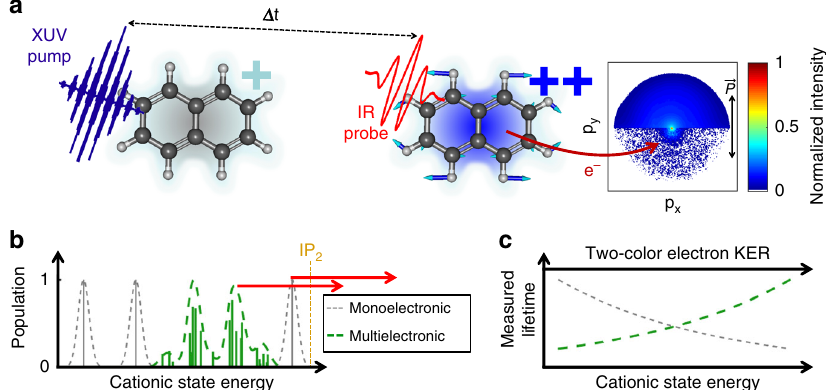
Fig. 1 Ultrafast correlation-driven relaxation dynamics of naphthalene cation. a A short XUV pump pulse is followed by a time-delayed short IR probe pulse which interacts with the Naph (or Ada) molecules. The light polarization is set parallel to the detector. The emitted photoelectrons are collected with a velocity map imaging spectrometer, allowing measurement of the electron-momentum distribution as a function of the delay between pulses. b The cationic states produced by the XUV ionization have strong multielectronic character which leads to a complex structure in which multielectronic (in green) and vibrational degrees of freedom are all strongly coupled. c The IR pulse produces electrons that probe the dynamics of these states revealing an energy dependence of the lifetime intrinsic to the many-body character of the molecular states (green